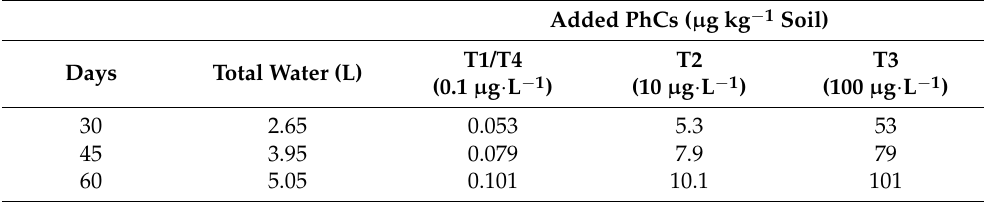
Table 1. Total quantity of the water and selected PhCs added to each pot during the